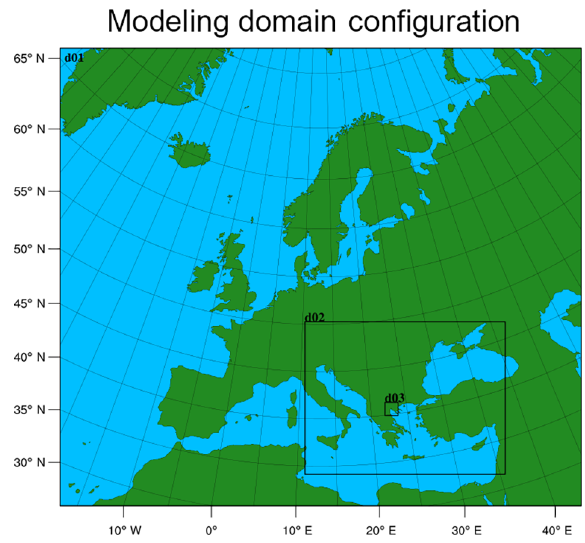
Figure 1. The three domains of CAMx: the European domain (d01), the Balkan domain (d02) and the domain of Thessaloniki (d03). A nesting technique is applied in order to increase the accuracy in the inner